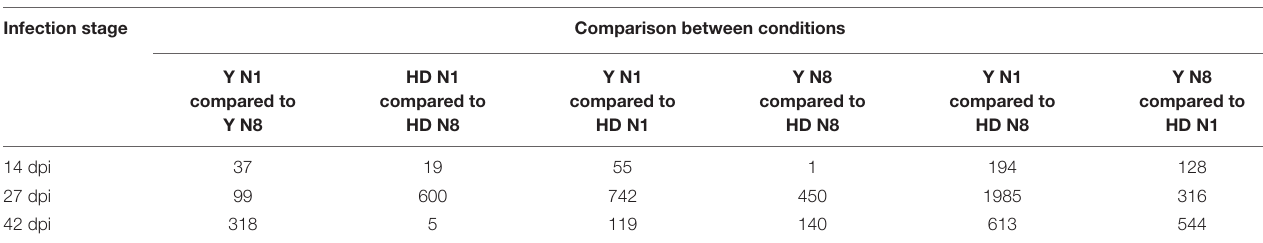
FIGURE 1 | Influence of nitrogen supply on plant biomass and clubroot development. The dry aerial parts (A) and roots (B) were weighed for both inoculated genotypes (Y, Yudal and HD, HD-018) at different days post-inoculation (14, 27, or 42 dpi), and for each N condition supply (N1, 1 mM and N8, 8 mM nitrogen). The clubroot symptoms were estimated according to the disease index and the quantification of P. brassicae DNA by qPCR expressed as a ratio of the 18S DNA quantity relative to the total DNA (C) . Data are means of four biological replicates (6–24 pooled plants per time, per plant genotype, and per replicate), and error bars represent standard errors of the means. Means with different letters are statistically significantly different according to the analysis of variance test ( P < 0.05). TABLE 1 | Number of Plasmodiophora brassicae DEGs for each comparison of